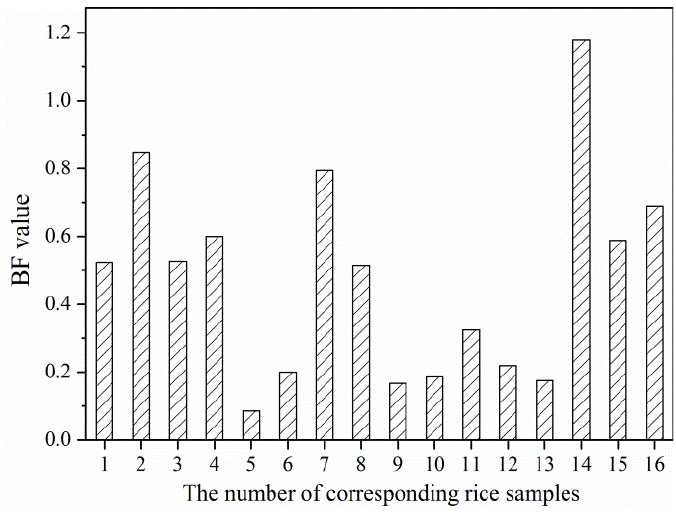
Figure 6. The BF value of Cd in these rice grains.